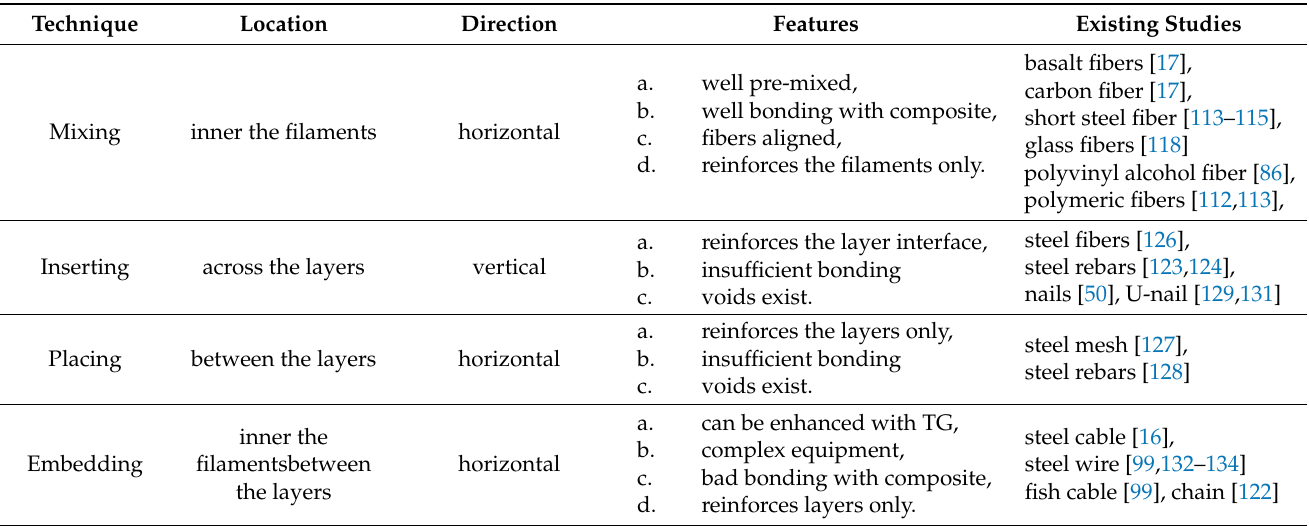
Table 2. Existing reinforcing techniques.